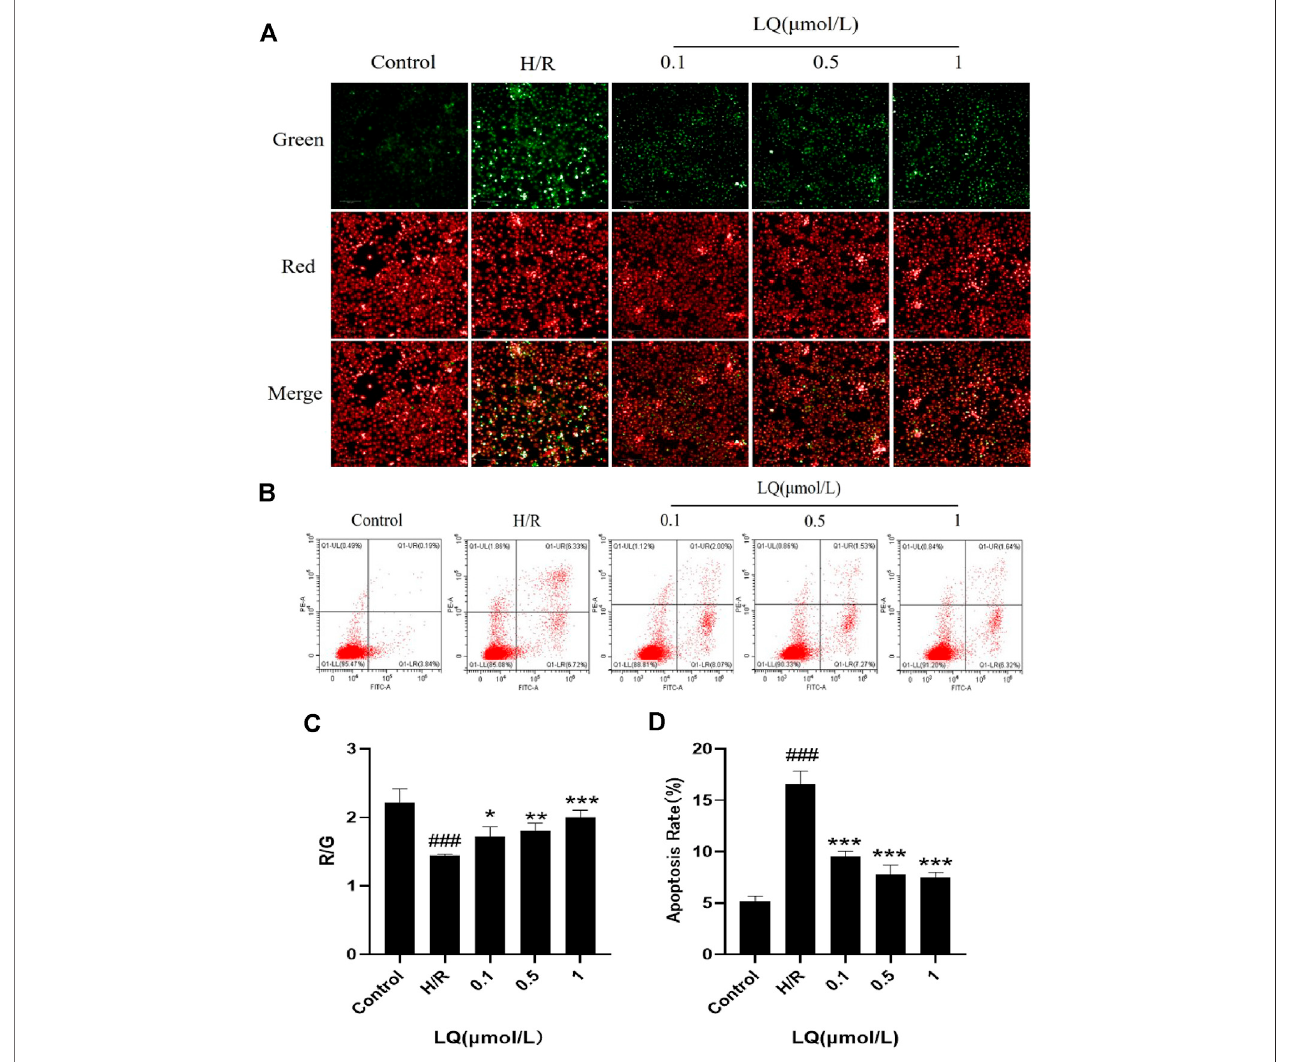
FIGURE 3 | LQ can reduce apoptosis. (A, C) The mitochondrial membrane was increased by LQ. Green represents the decrease of membrane potential and red wasincreased. The results are expressed as the intensity of red fl uorescence relative to green fl uorescence. (B, D) The upper left corner represents necrotic cells due to mechanical injury, the upper right corner represents late apoptotic cells, the lower left corner represents normal cells, and the lower right corner represents early apoptosis. Flow cytometry detection of LQ can reduce cell apoptosis. ### p < 0.001, compared to control. * p < 0.05, ** p < 0.01, *** p < 0.001, compared to H/R.